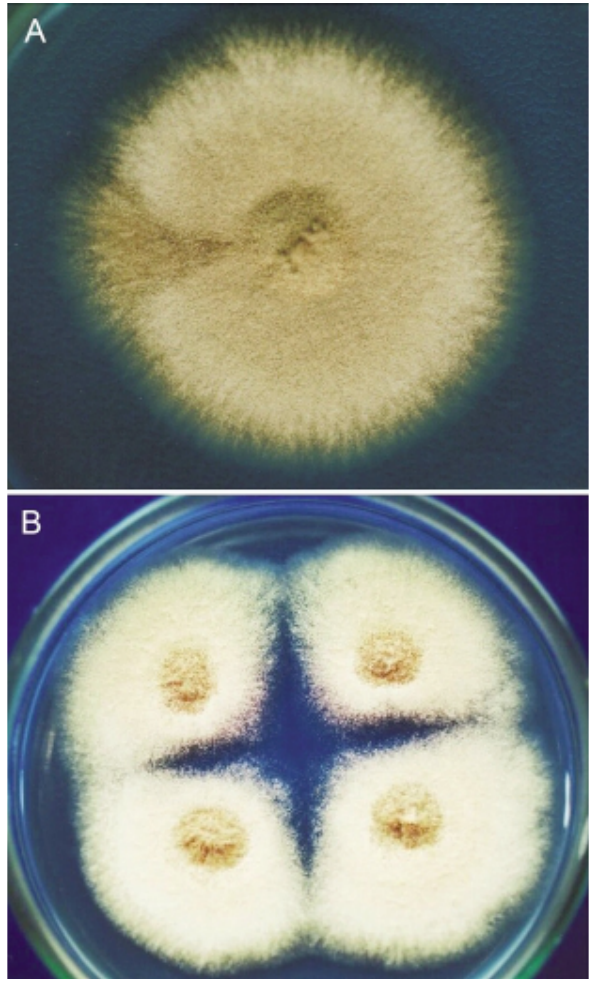
Figure 2 - (A) Mitotic instability of diploid strain D19 obtained after so- dium nitroprusside treatment (160 (cid:1) M) of diploid strain UT448//A757; (B) stable mitotic segregant derived from strain